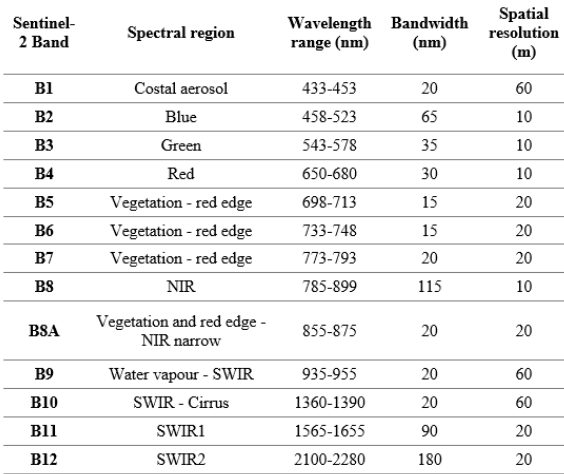
Table 1. Sentiel-2 multispectral